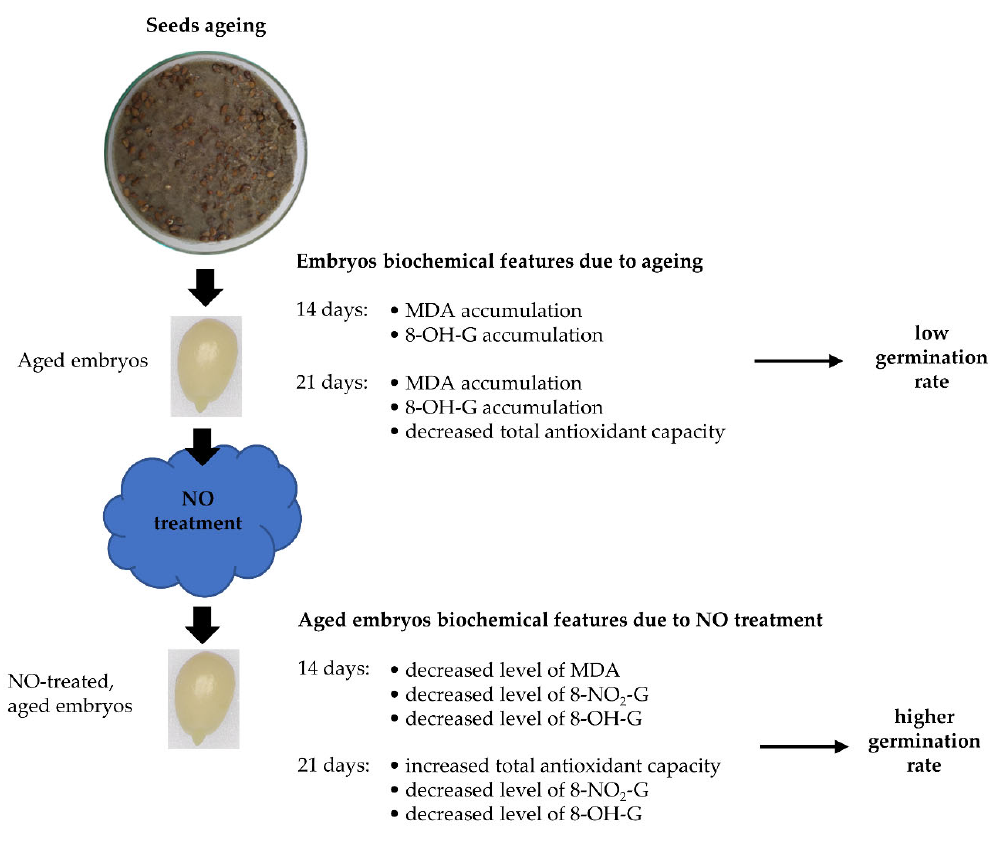
Figure 9. The simplified model of alterations in some biochemical features of the embryos isolated from apple seeds undergoing aging for 14 or 21 days. These embryos are characterized by the low germinability. The parameters are chosen in comparison to the embryos isolated from seeds aged for 7 days. NO beneficial effect on the embryos isolated from aged seeds refers to modification of identified biochemical attributes, leading to the restoration of high germination rate (after 14 days) or the prevention of the drastic decrease in germination rate (after 21 days). The features are chosen based on the difference of the parameters values between the aged and NO ‐ treated aged embryos.